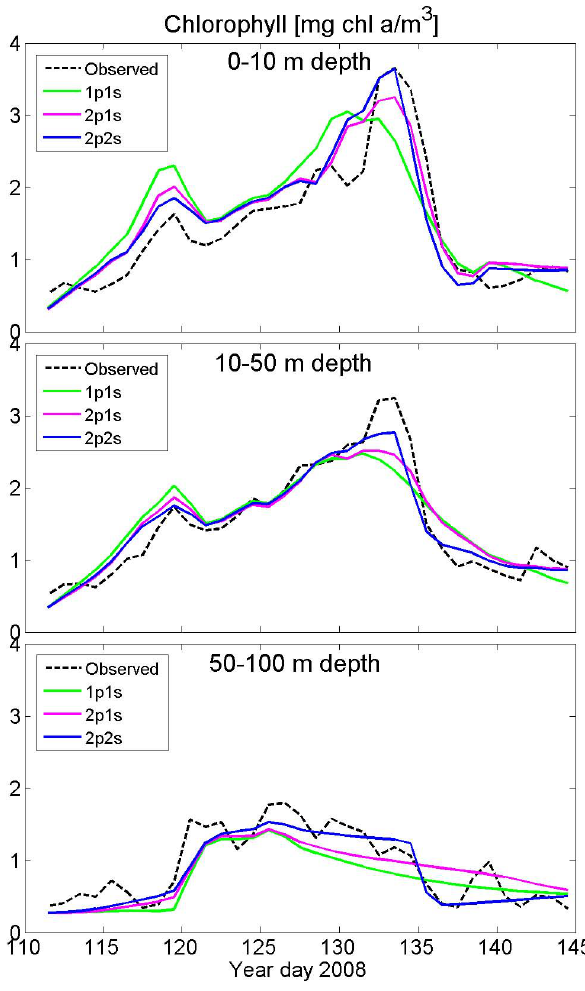
Fig. 4. Observed and simulated mean chlorophyll concentrations for different depth intervals.